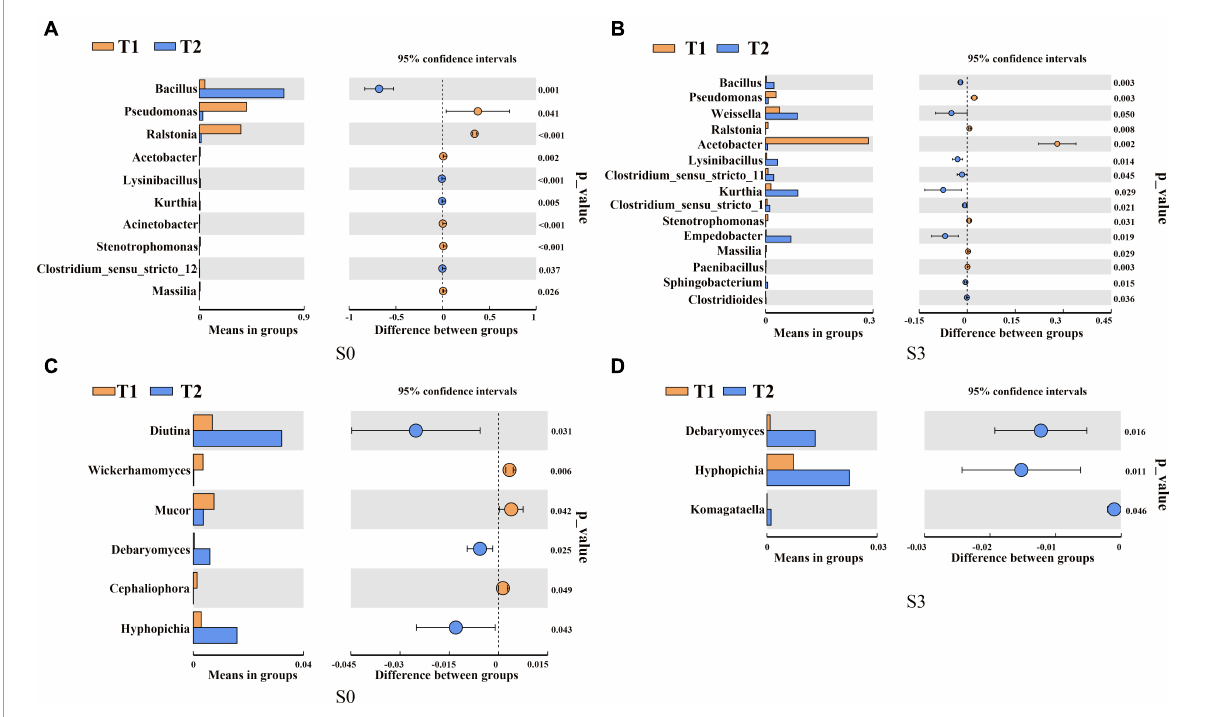
FIGURE3 T -test of bacterial and fungal communities in fermented rapeseed cake. (A) The t -test of bacterial communities in fermented rapeseed cake in S0. (B) The t -test of bacterial communities in fermented rapeseed cake in S3. (C) The t -test of fungal communities in fermented rapeseed cake in S0. (D) The t -test of fungal communities in fermented rapeseed cake in S3.